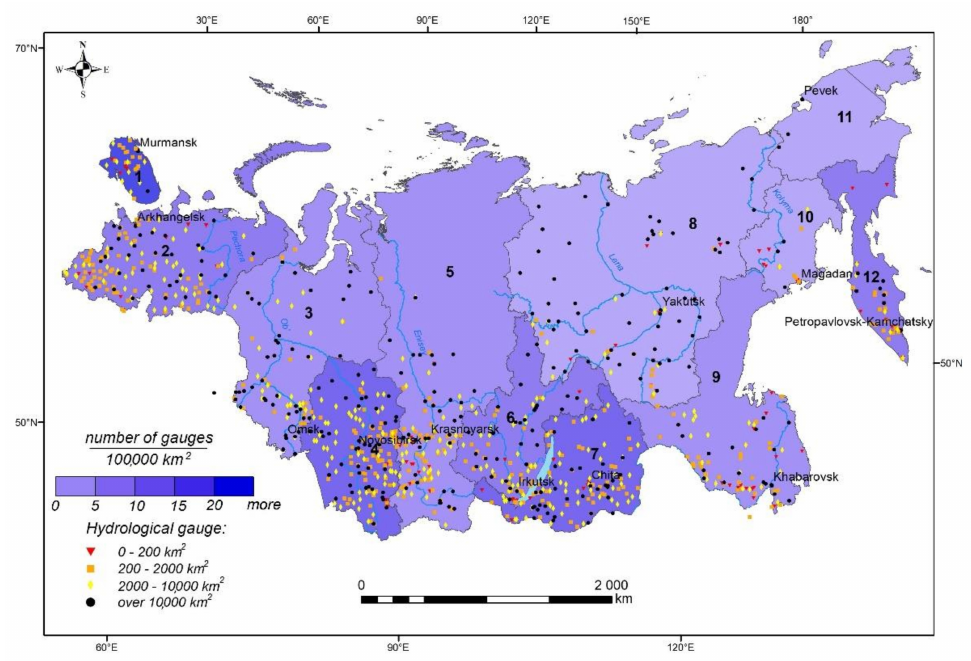
Figure 2. Total density (number of gauges per 100,000 km 2 ) and location of hydrological network with streamflow observations in the departments of Russian Hydrometeorological Service of permafrost zone (DHS, the numbers correlate to Tables 1 and 2) by